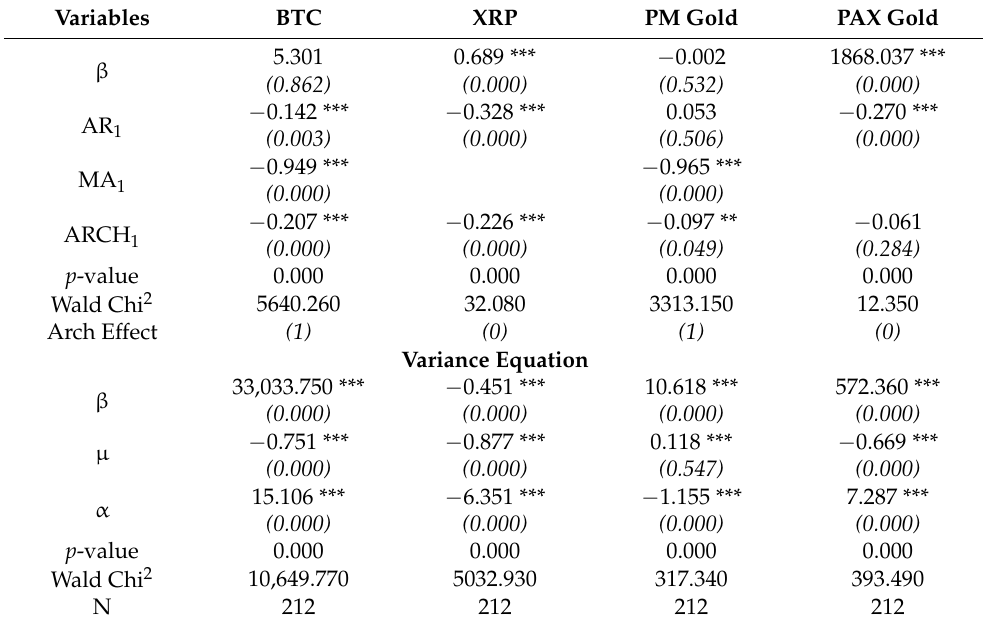
Table 5. Outcomes of the ARIMA and EGARCH